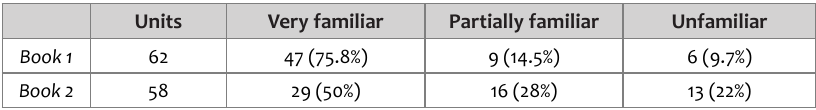
Table 3: Findings of the content